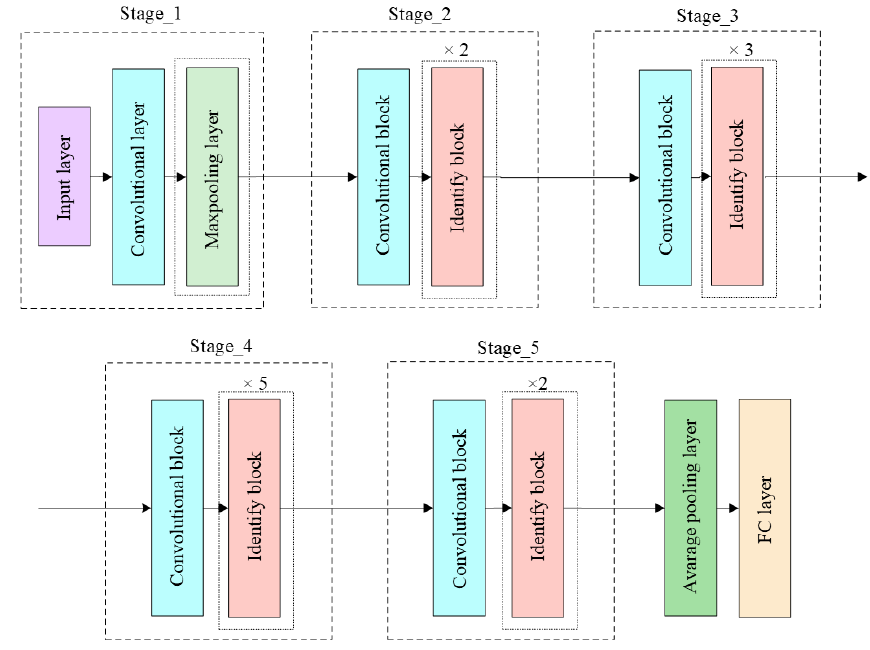
Figure 3. Resnet50 architecture